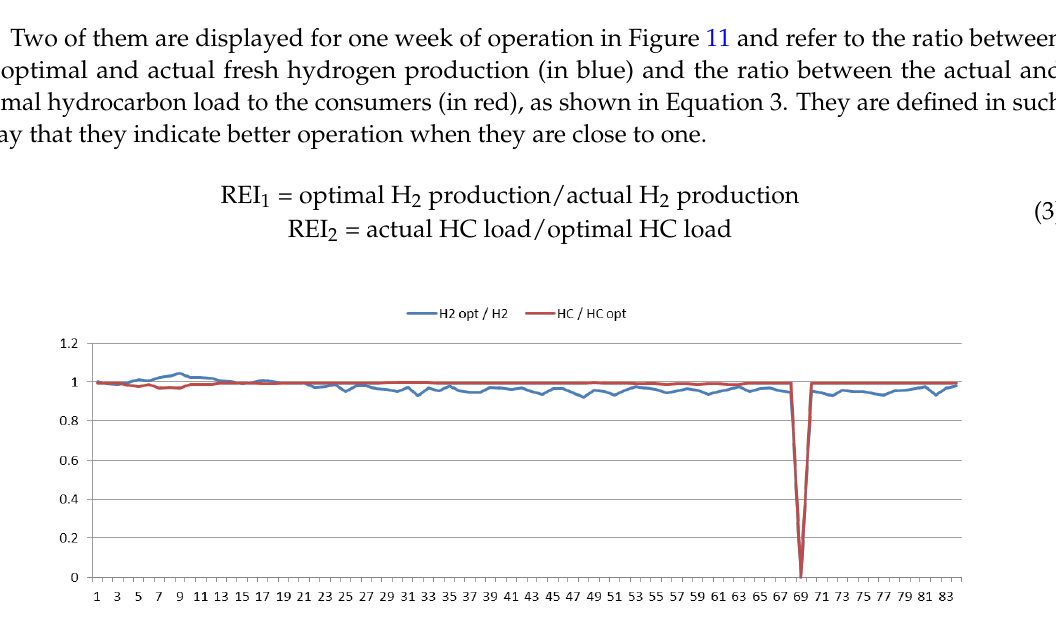
Figure 11. Two REIs showing the distance to the optimal achievable targets for one week of operation.